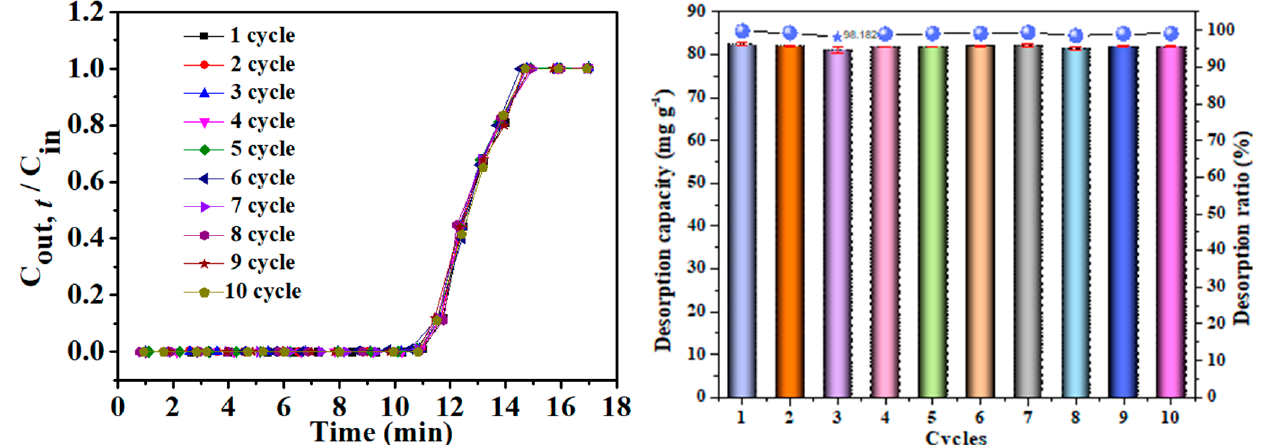
Figure 12. Adsorption breakthrough curves of L2 and β -CD-rGOA-0.5 desorption rate after cycles.